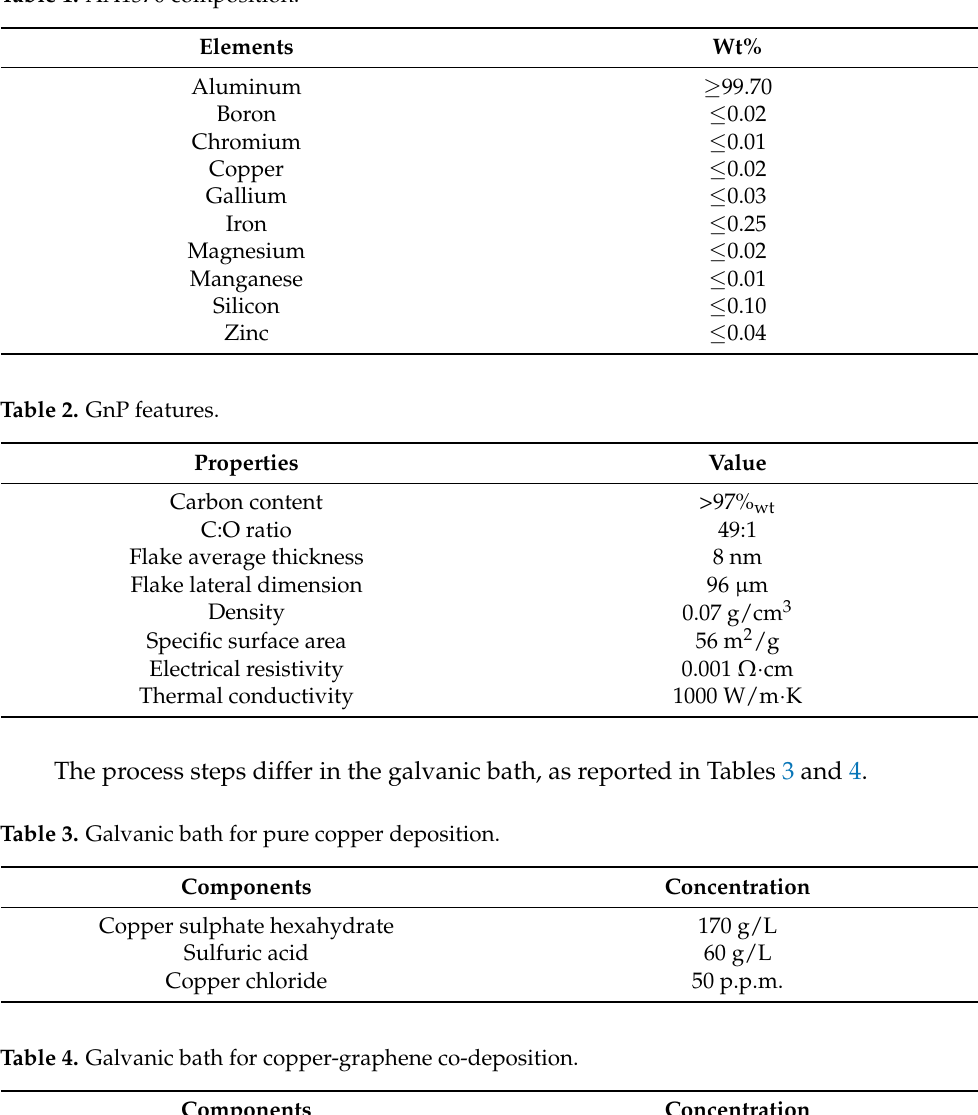
Table 1. AA1370 composition.